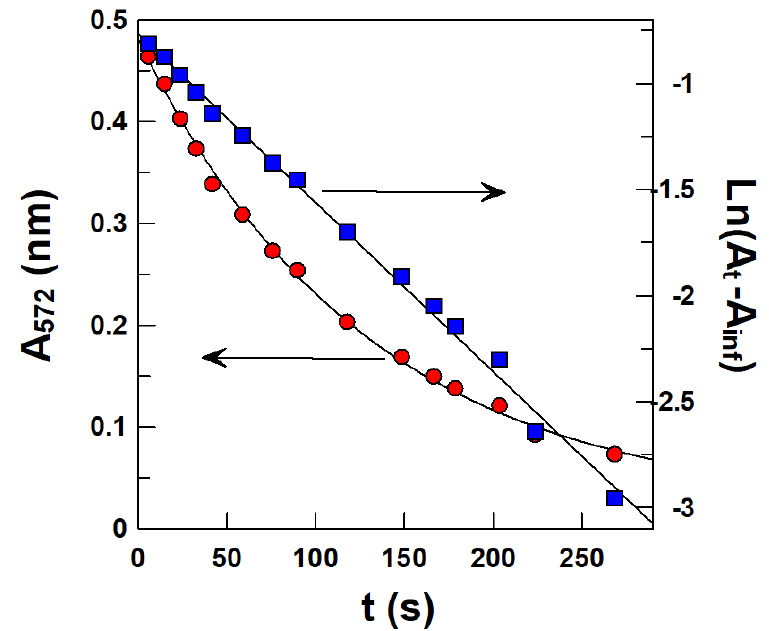
Figure 2. Typical plot showing the changes in absorbance ( λ = 572 nm) with time ( • ) and ln[A t − A inf ] plot ( (cid:4) ). Reaction was carried out in intact 1:9 ( v : v , o / w ) emulsions prepared by employing stripped olive oil, a buffered (pH = 5, citric acid/citrate (0.04 M)) aqueous solution, and Tween 20 (surfactant volume fraction Φ I = V surf /V total = 0.04). Experimental conditions: [16-ArN 2+ ] = 2.90 × 10 − 4 M, [ α -TOC] = 4.2 × 10 − 3 M, T = 25 ◦